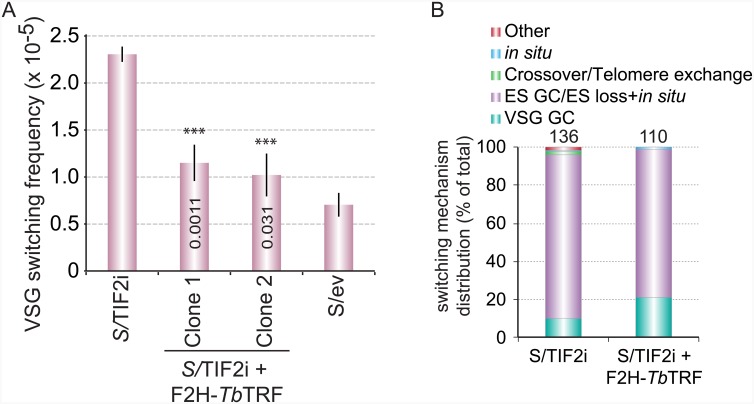
Expressing an ectopic F2H-TbTRF allele partially suppresses the phenotype of increased VSG switching frequency in TbTIF2 RNAi cells.(A) VSG switching frequencies in several strains. Averages were calculated from three independent experiments. Error bars represent standard deviations. Numbers labeled on middle columns are P values (unpaired t-test) calculated between switching frequencies in S/TIF2+F2H-TbTRF cells and that in S/ev cells. Asterisks represent P values (unpaired t-test) calculated between values in S/TIF2+F2H-TbTRF cells and that in S/TIF2i cells. ***, P<0.001. (B) VSG switching mechanisms in different strains. The total number of analyzed switchers in each strain was indicated on top of the corresponding column.